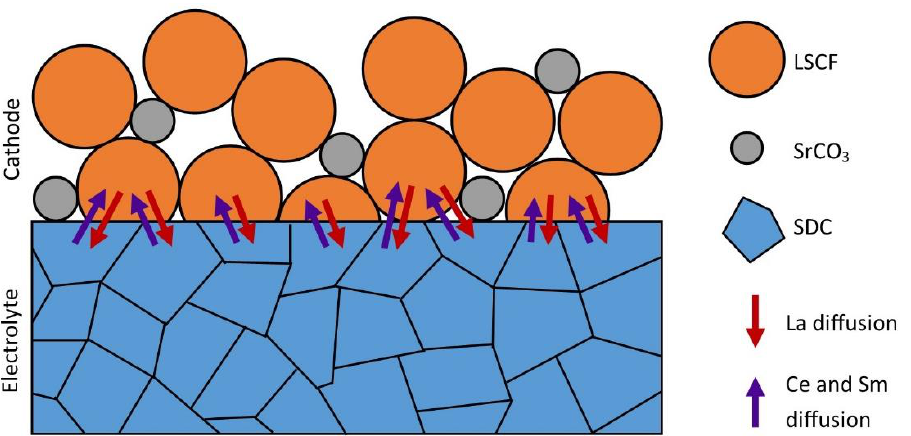
Figure 7. Schematic of the strontium segregation and lanthanum, cerium and samarium diffusion.